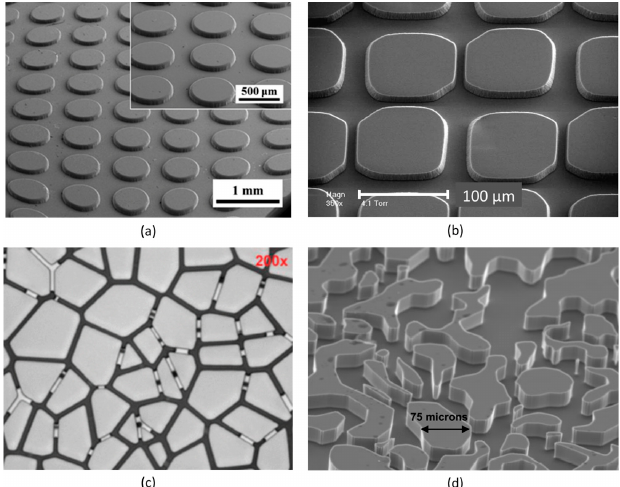
Figure 1. Examples of different pore network patterns: ( a ) regular (from Hsu et al. [15]), ( b ) partially-regular (from Auset & Keller [16]), ( c ) quasi-irregular (Xu et al. [17]), and ( d ) irregular (from Rangel-German & Kovscek [18]). (Reprinted with permission from [15–18]).